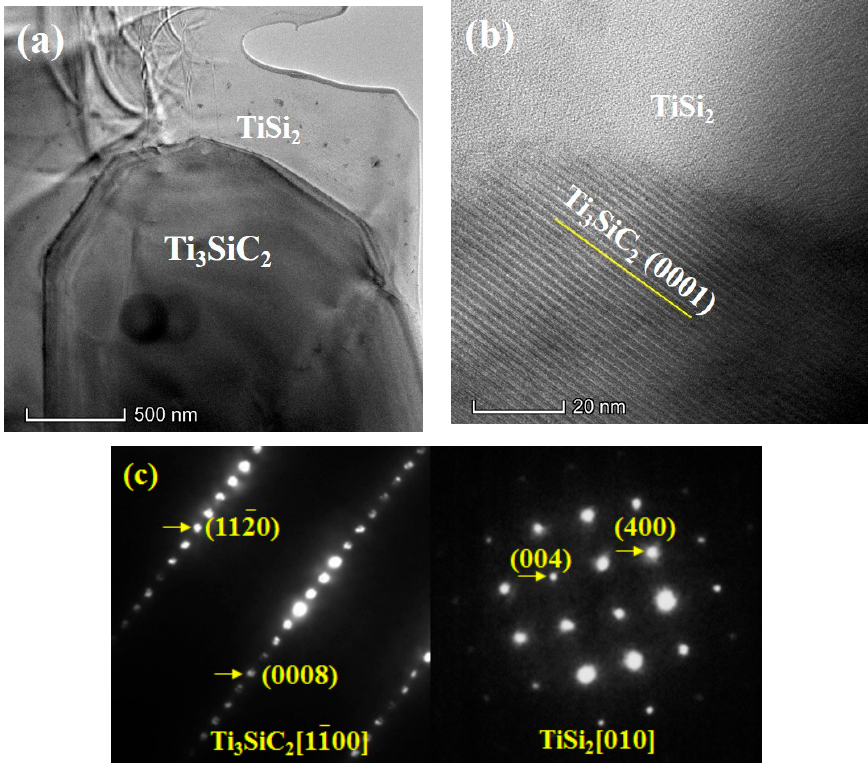
Figure 2. ( a ) Low-magnification and ( b ) high-resolution TEM images showing Ti 3 SiC 2 and TiSi 2 , ( c ) and the corresponding selected area electron diffraction patterns.